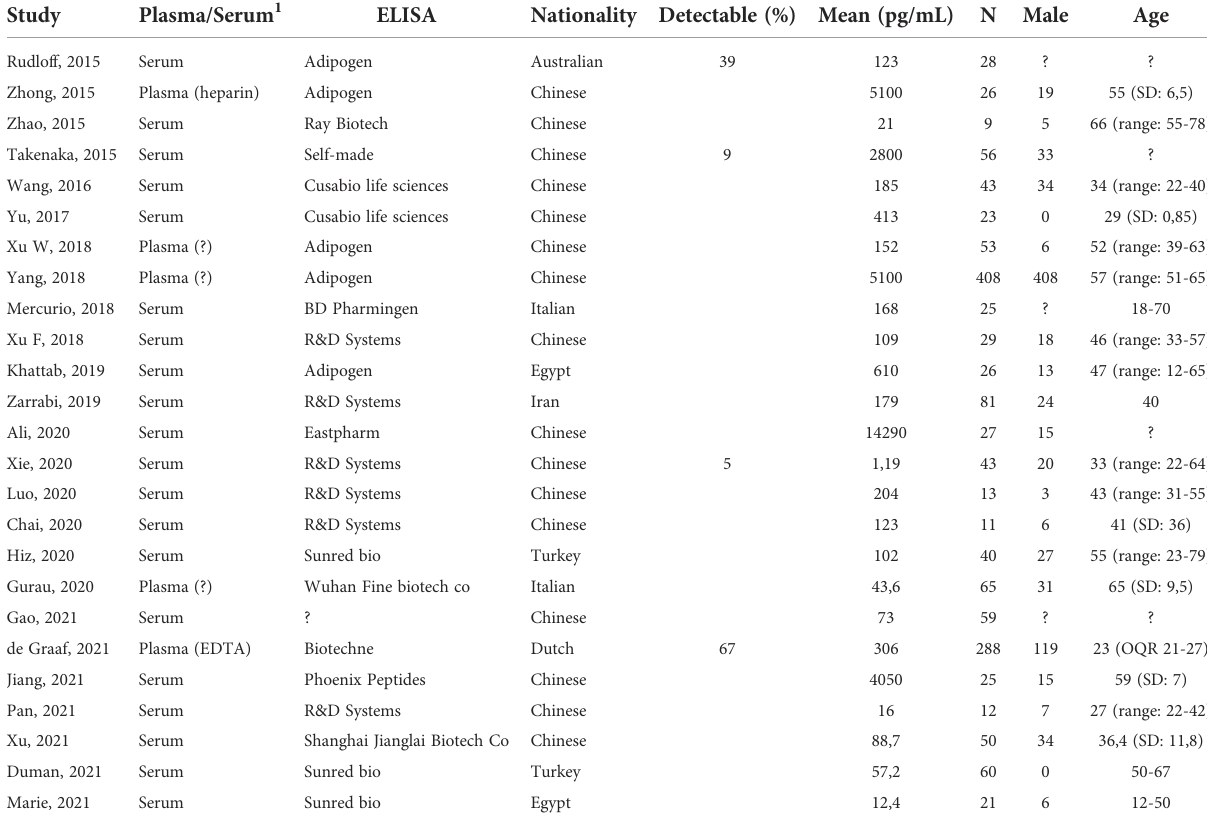
TABLE 2 An overview of the study and healthy volunteer characteristics of all included studies.